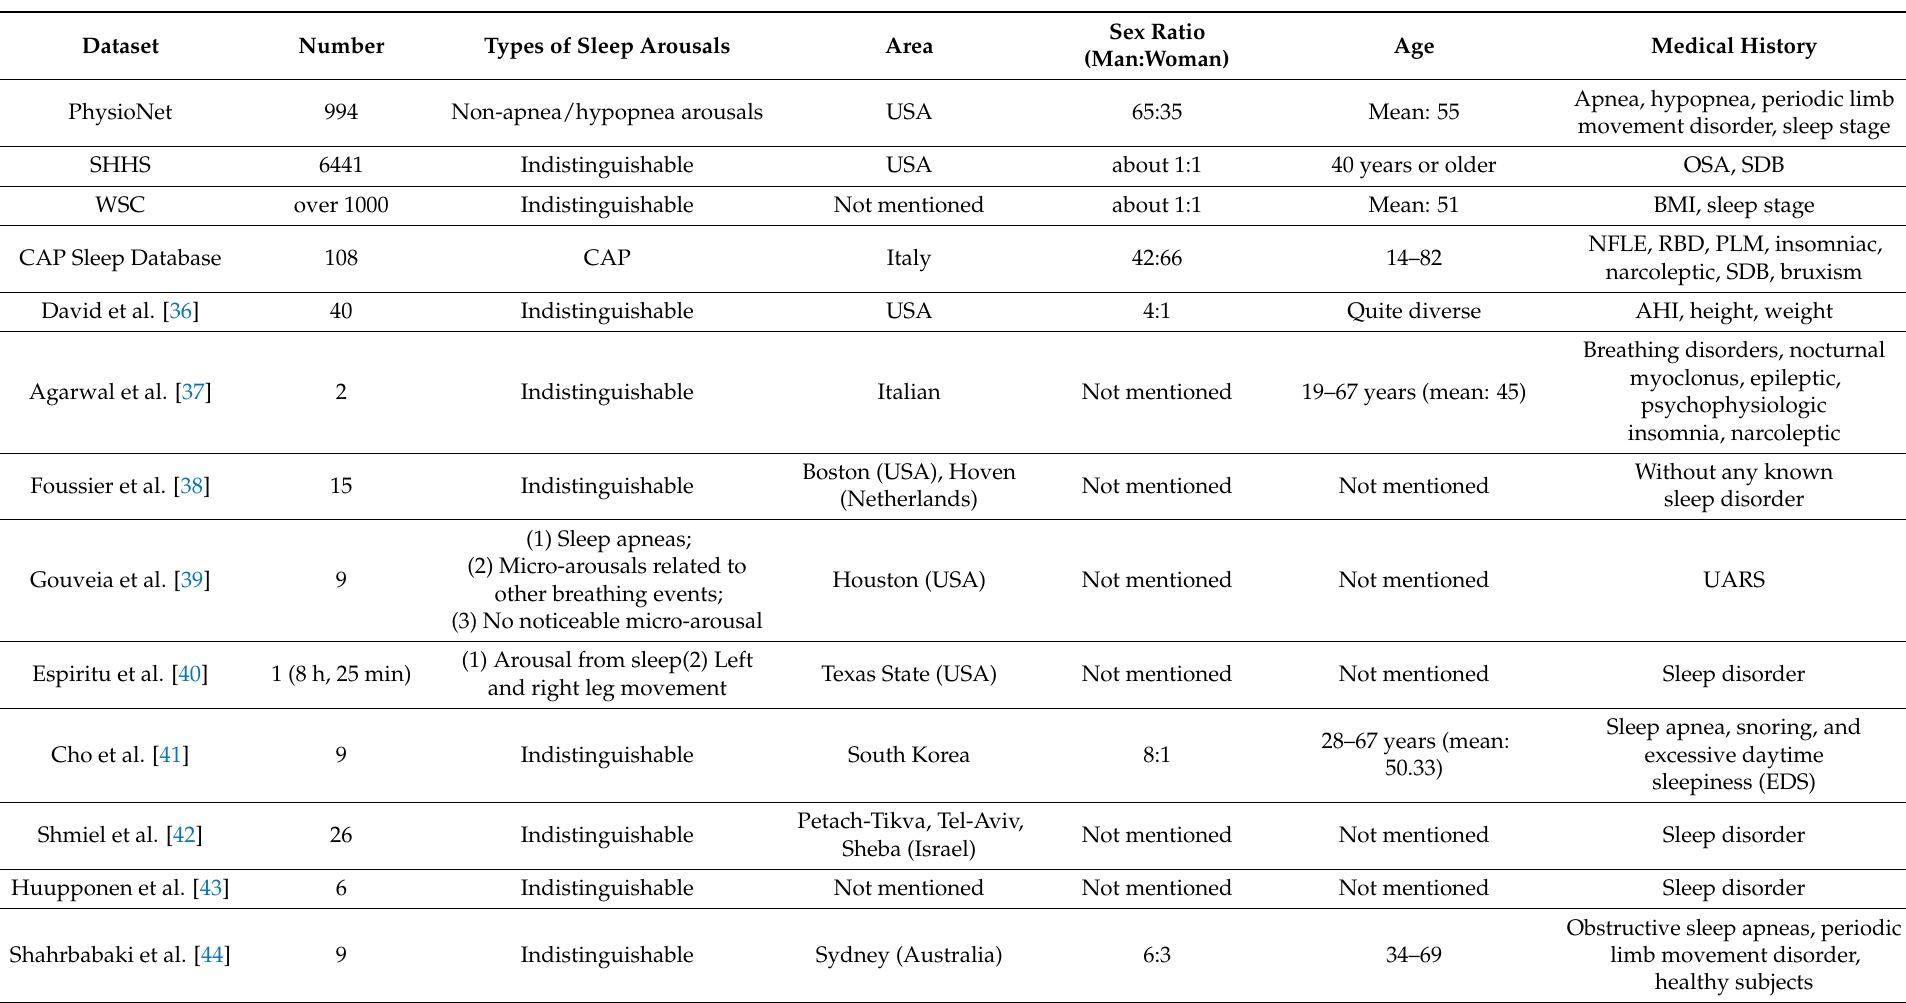
Table 1. Comprehensive comparison of